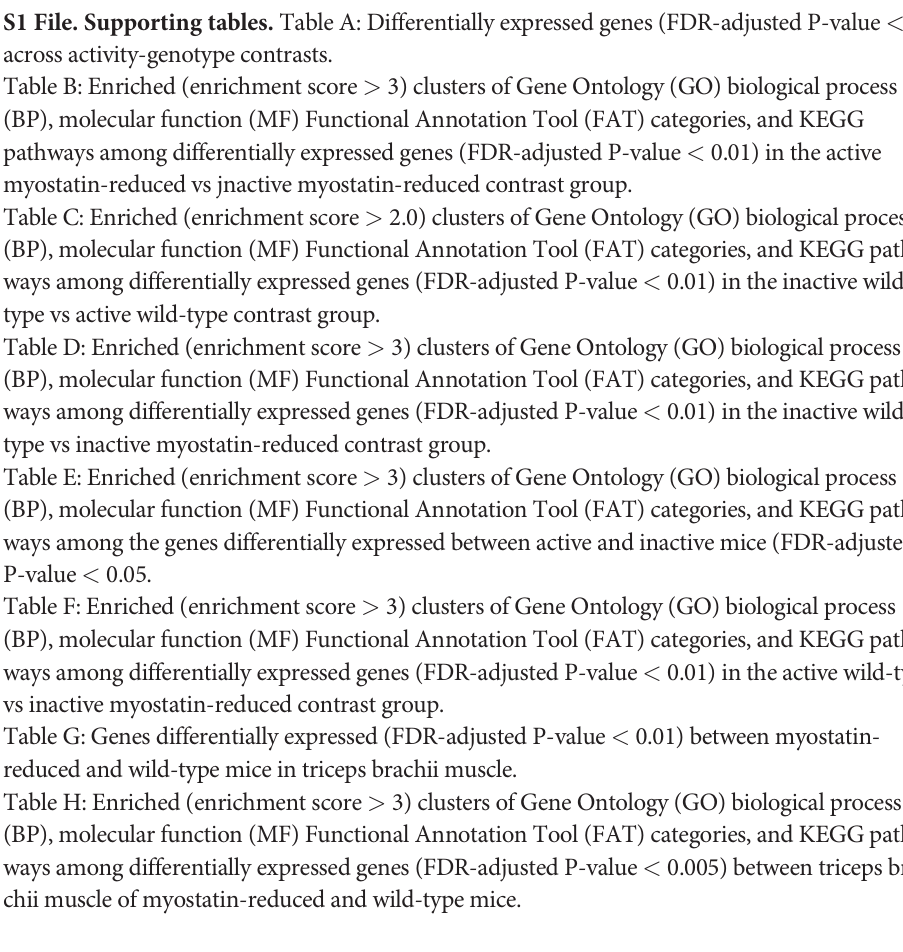
S1 File. Supporting tables. Table A: Differentially expressed genes (FDR-adjusted P-value < .01) across activity-genotype contrasts. Table B: Enriched (enrichment score > 3) clusters of Gene Ontology (GO) biological process (BP), molecular function (MF) Functional Annotation Tool (FAT) categories, and KEGG pathways among differentially expressed genes (FDR-adjusted P-value < 0.01) in the active myostatin-reduced vs jnactive myostatin-reduced contrast group. Table C: Enriched (enrichment score > 2.0) clusters of Gene Ontology (GO) biological process (BP), molecular function (MF) Functional Annotation Tool (FAT) categories, and KEGG path- ways among differentially expressed genes (FDR-adjusted P-value < 0.01) in the inactive wild- type vs active wild-type contrast group. Table D: Enriched (enrichment score > 3) clusters of Gene Ontology (GO) biological process (BP), molecular function (MF) Functional Annotation Tool (FAT) categories, and KEGG path- ways among differentially expressed genes (FDR-adjusted P-value < 0.01) in the inactive wild- type vs inactive myostatin-reduced contrast group. Table E: Enriched (enrichment score > 3) clusters of Gene Ontology (GO) biological process (BP), molecular function (MF) Functional Annotation Tool (FAT) categories, and KEGG path- ways among the genes differentially expressed between active and inactive mice (FDR-adjusted P-value < 0.05. Table F: Enriched (enrichment score > 3) clusters of Gene Ontology (GO) biological process (BP), molecular function (MF) Functional Annotation Tool (FAT) categories, and KEGG path- ways among differentially expressed genes (FDR-adjusted P-value < 0.01) in the active wild-type vs inactive myostatin-reduced contrast group. Table G: Genes differentially expressed (FDR-adjusted P-value < 0.01) between myostatin- reduced and wild-type mice in triceps brachii muscle. Table H: Enriched (enrichment score > 3) clusters of Gene Ontology (GO) biological process (BP), molecular function (MF) Functional Annotation Tool (FAT) categories, and KEGG path- ways among differentially expressed genes (FDR-adjusted P-value < 0.005) between triceps bra- chii muscle of myostatin-reduced and wild-type